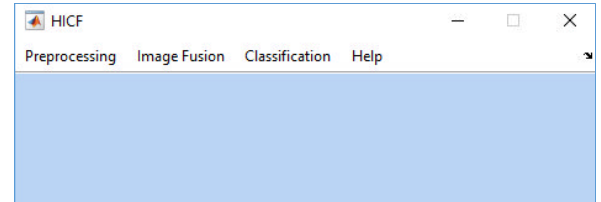
Figure 3. The primary interface of the HICF package which includes the tabs for application based processing.